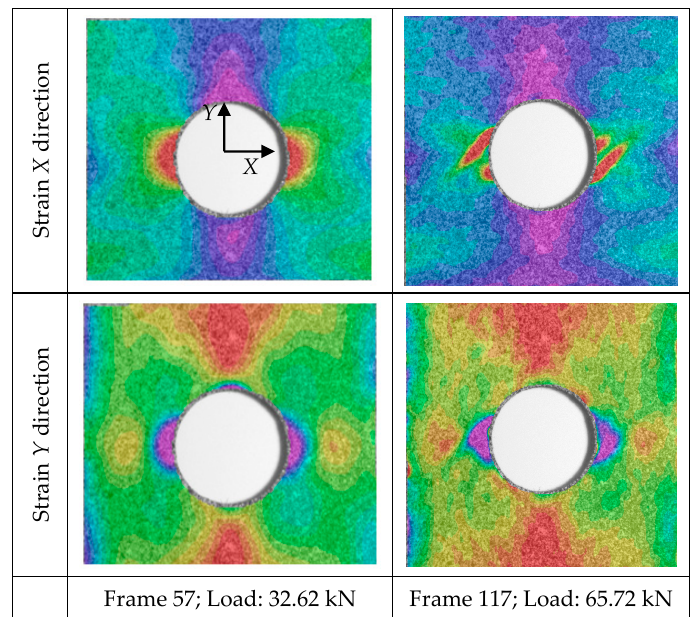
Figure 12. Strain distribution in X and Y directions for two different load steps.